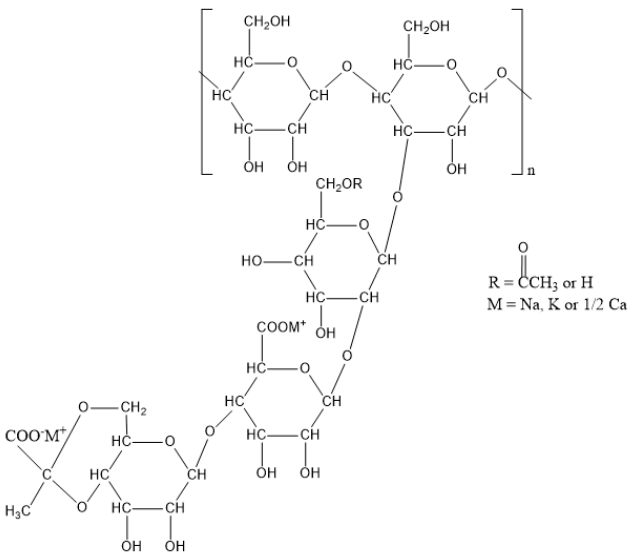
Figure 2. The molecular structure of Xanthan gum.